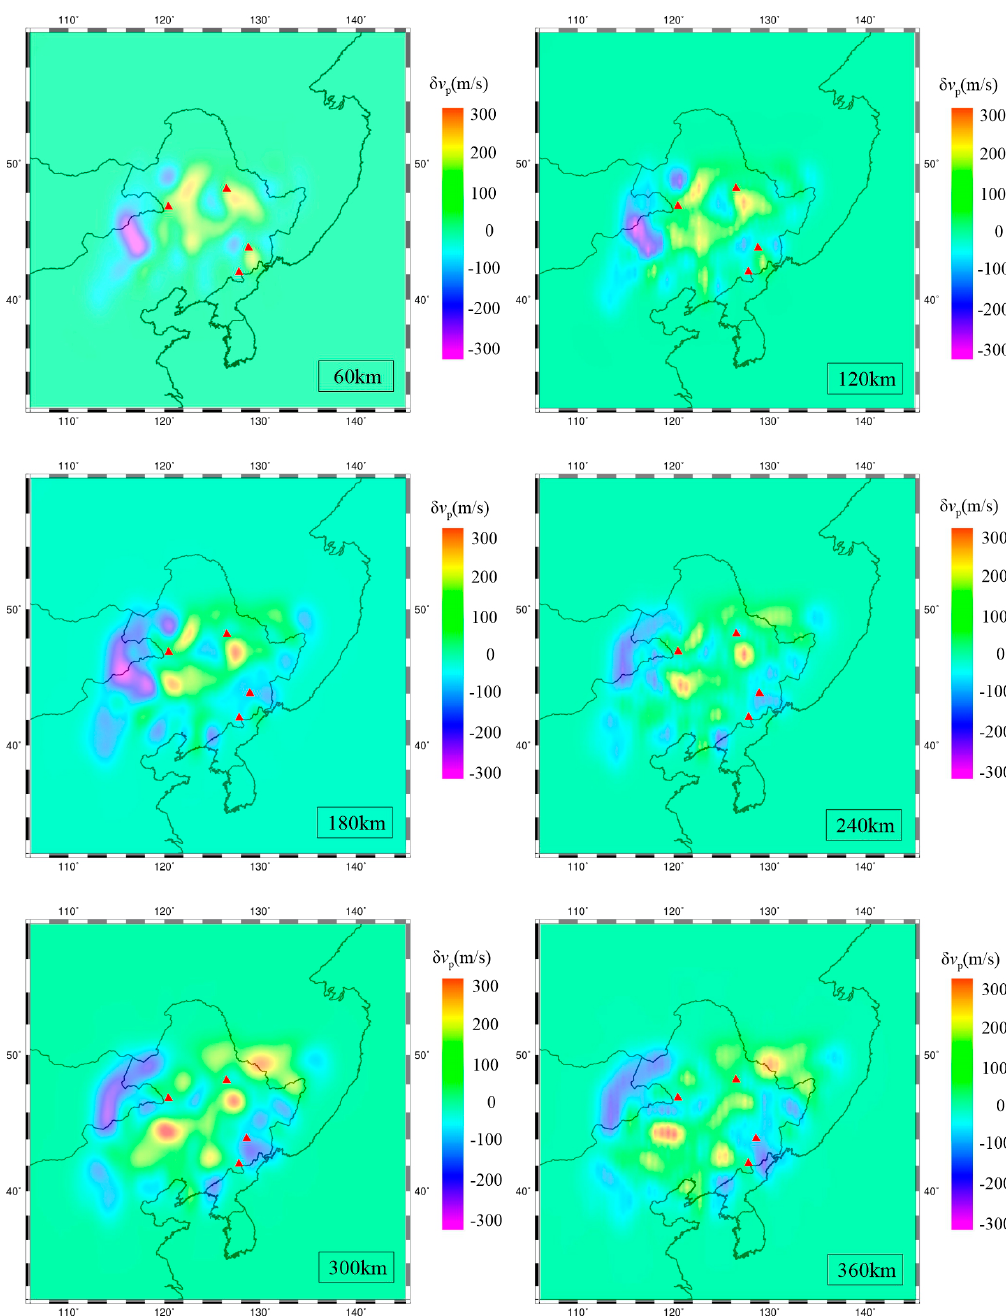
Figure 9. Horizontal section of P-wave velocity disturbance in the upper mantle of the study area (60–360 km).